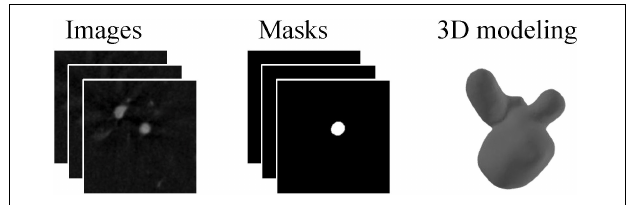
FIGURE 1 | An example case for angiographic image of the aneurysm and corresponding two types of segmentation